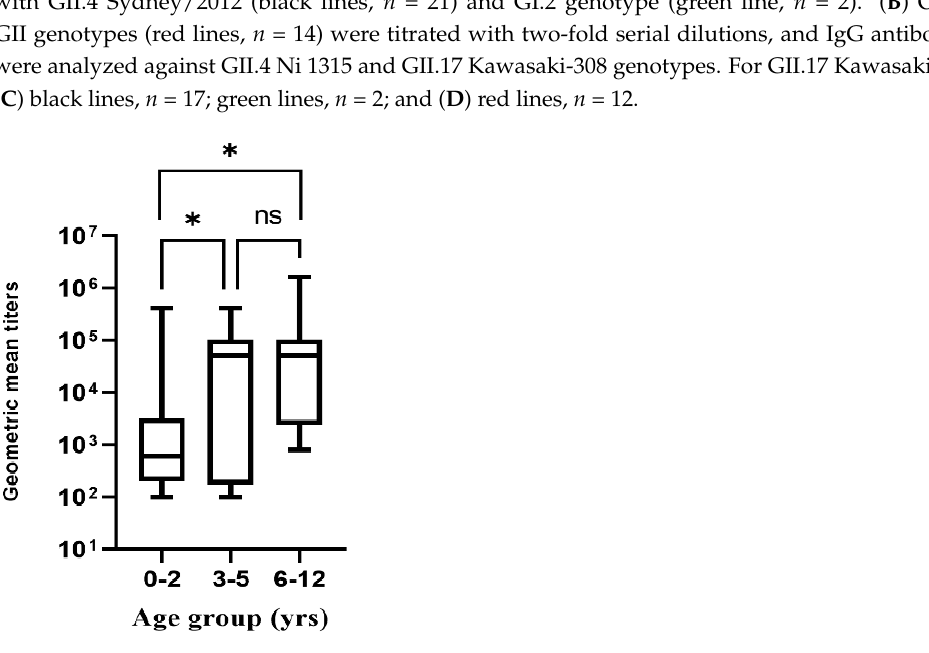
Figure 3. NoV pre-existing antibody titer responses for different age groups. * p < 0.05, ns: not sig- nificant.